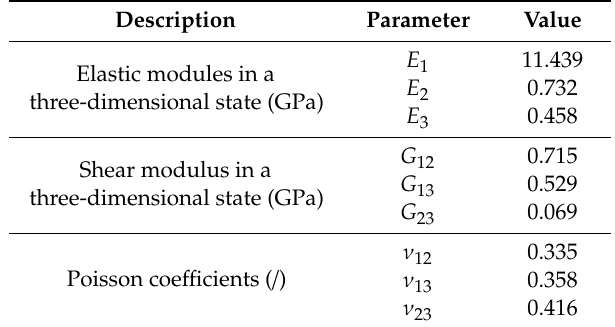
Table 2. Average wood properties in laboratory tests and Reference